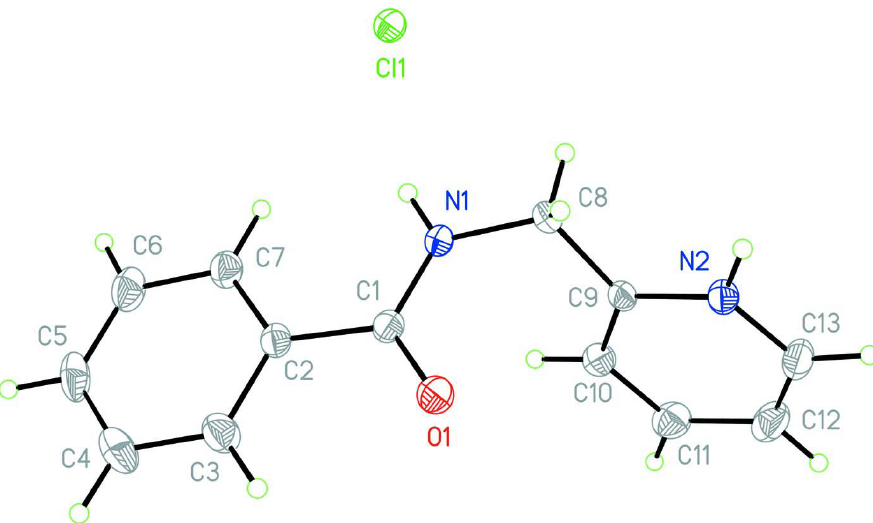
Figure 1 The molecular structure of the title compound with the atom-labeling scheme. Ellipsoids are drawn at the 40% probability level. H atoms are represented as smal spheres of arbitrary radii.